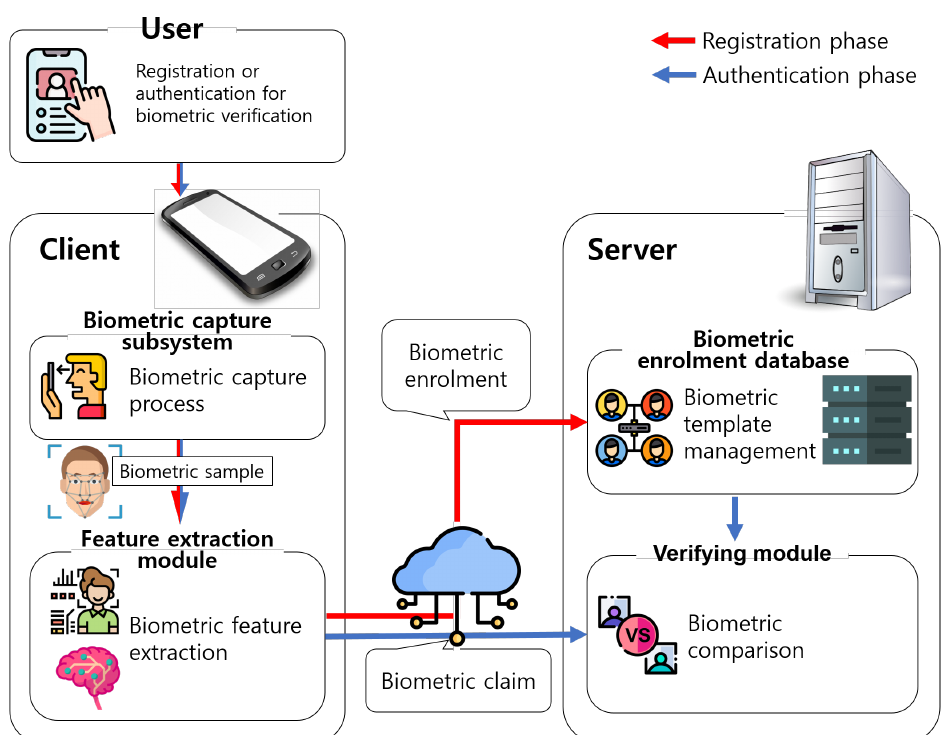
Figure 1. Generic structure of a remote biometric verification